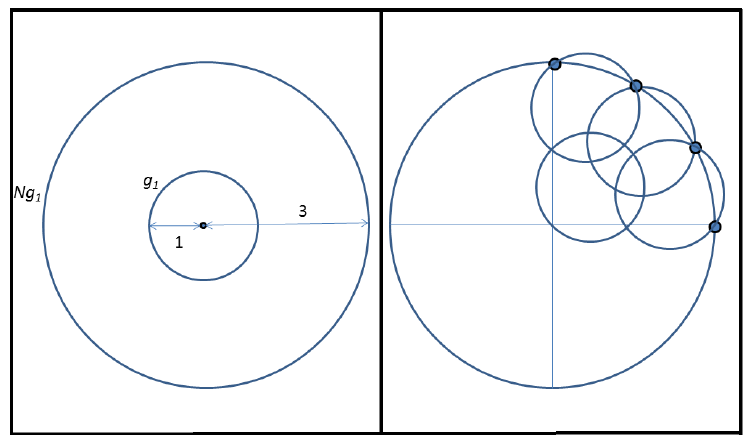
Fig. 4: The disks which have common points with g 1 are located in a disk with the same center as g 1 and a radius of 3, which is shown on the right side of this figure. We call this region Ng 1 . We can cover the Ng 1 region with at most 16 unit disks as depicted in the left side of this